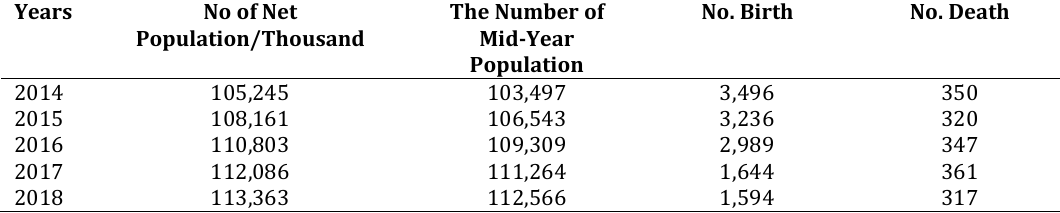
Source : Halabja Stastisics Office, 2/11/2019 and the General Directorate of Health of Halabja. 10/11/2019 and the Net Number of Population in 2019